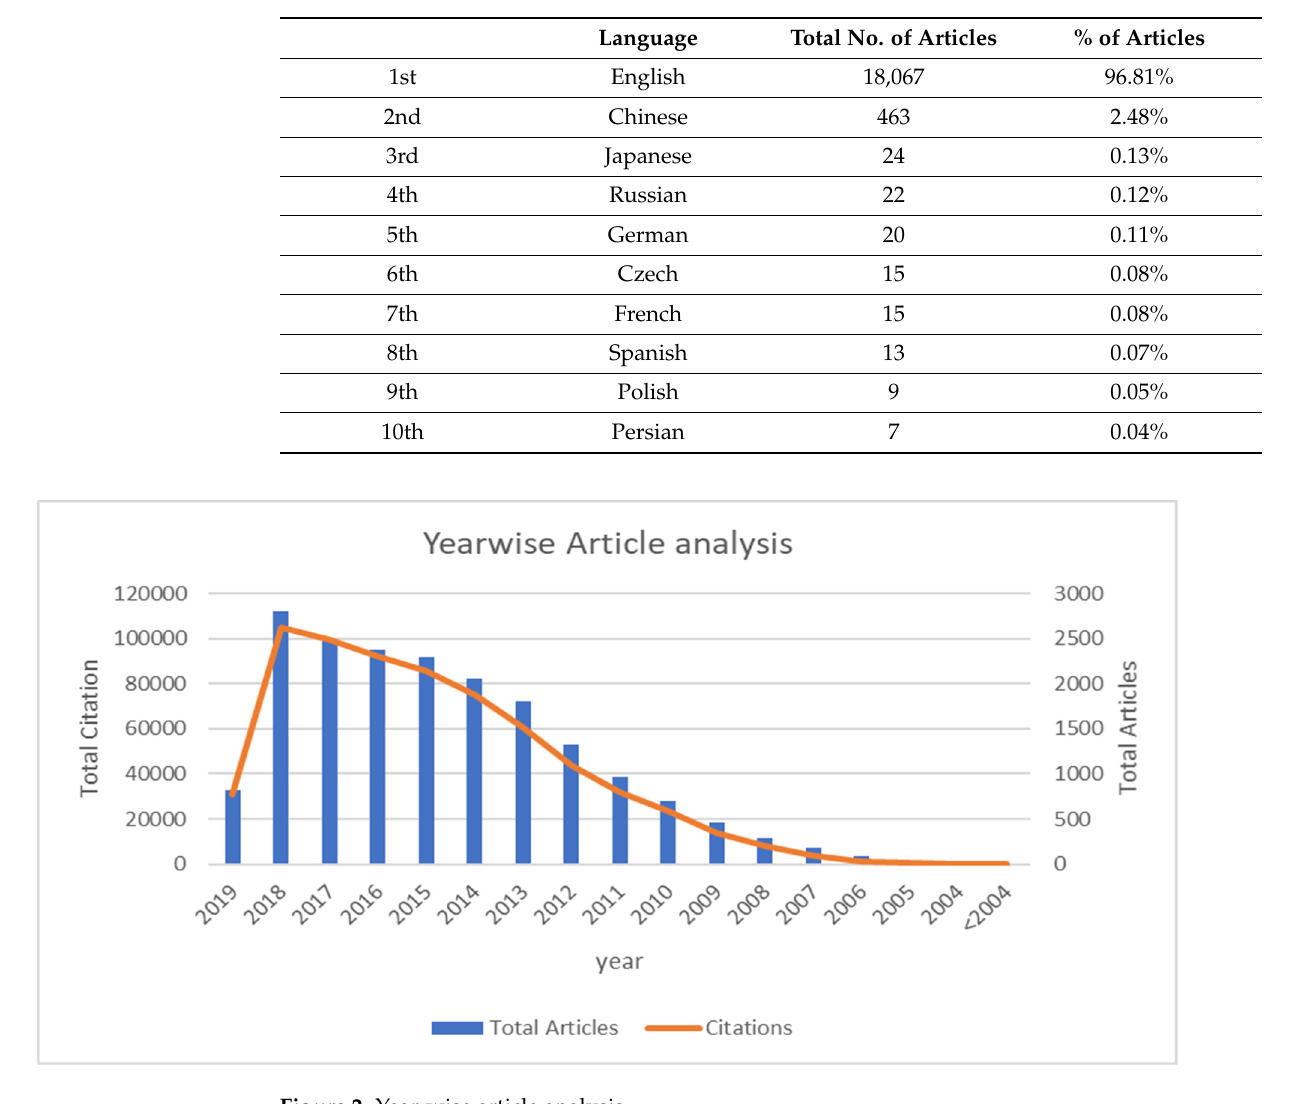
Table 3. Number of published articles and citations per year (2003–2019).